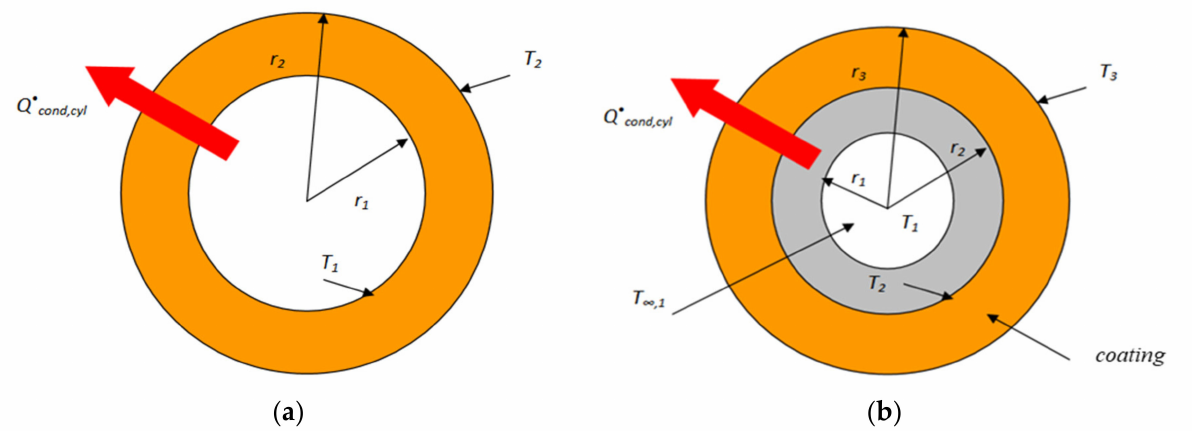
Figure 5. Heat flux exchanged by conduction in a pipe where the inner temperature is higher than the outer one. Left side ( a ) is a single layer pipe and the right side ( b ) is a pipe with a coating layer (not in